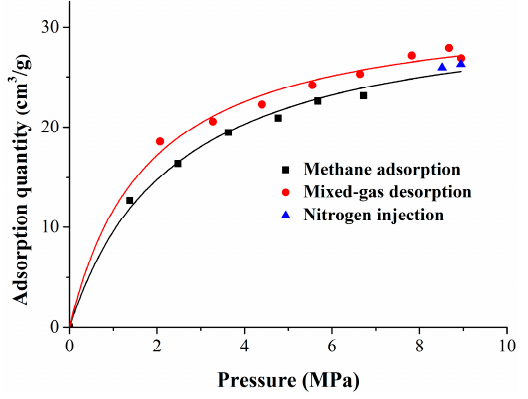
Figure 1. Isothermal adsorption and desorption curves.